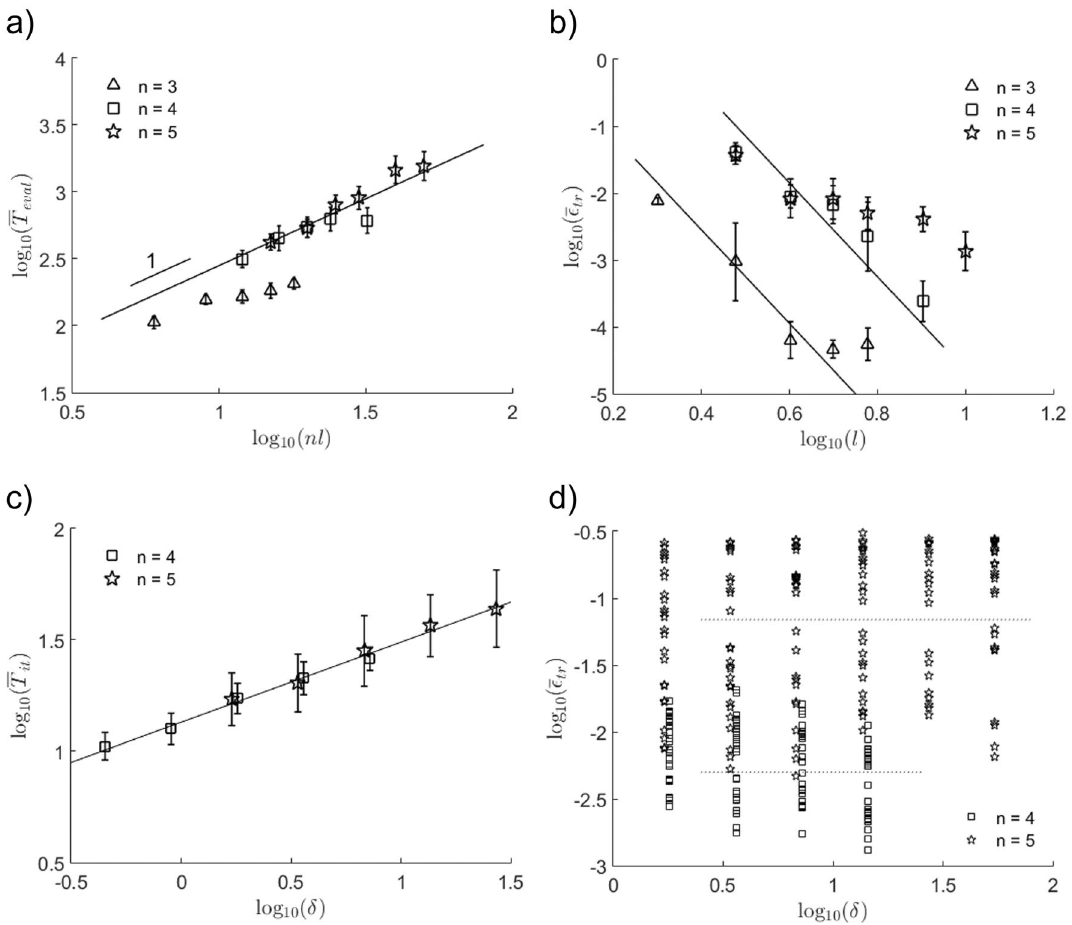
Figure 3. Logarithmic plots of time-averaged ( a ) number of function evaluations ¯ T eval vs. number of parameters nl , ( b ) trace error diffusion parameter δ for l standard deviation out of 25